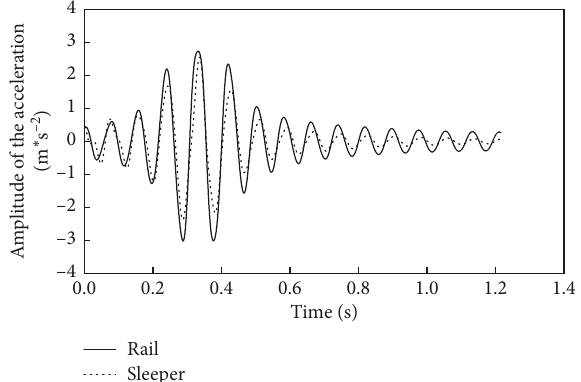
Figure 4: Rail and sleeper vibration acceleration time-domain amplitude.